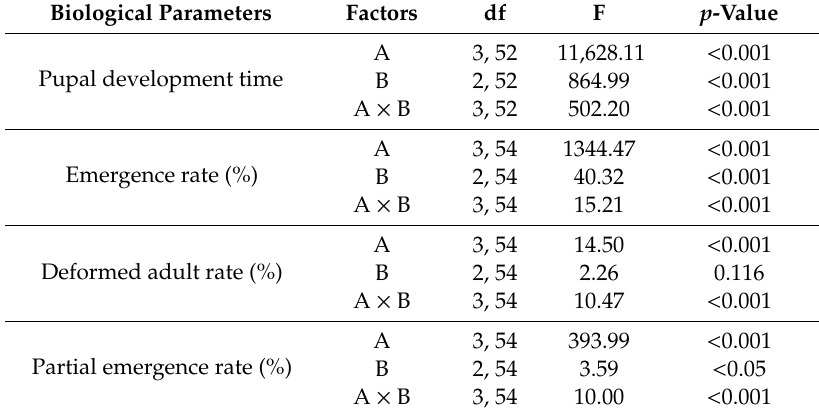
Table 1. Univariate analysis of e ff ects of factors on development parameters and fitness traits (flight ability, fecundity, dry weight) of B. dorsalis (genetic sexing strains (GSS)). Biological